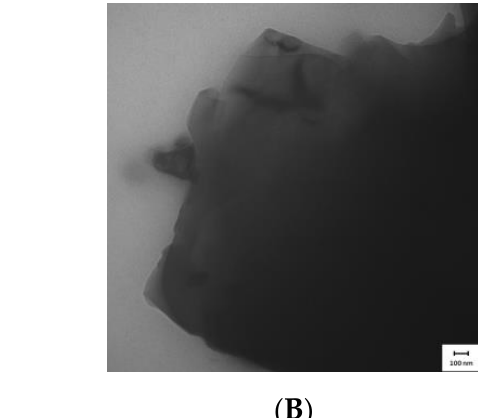
corroborated this migration.